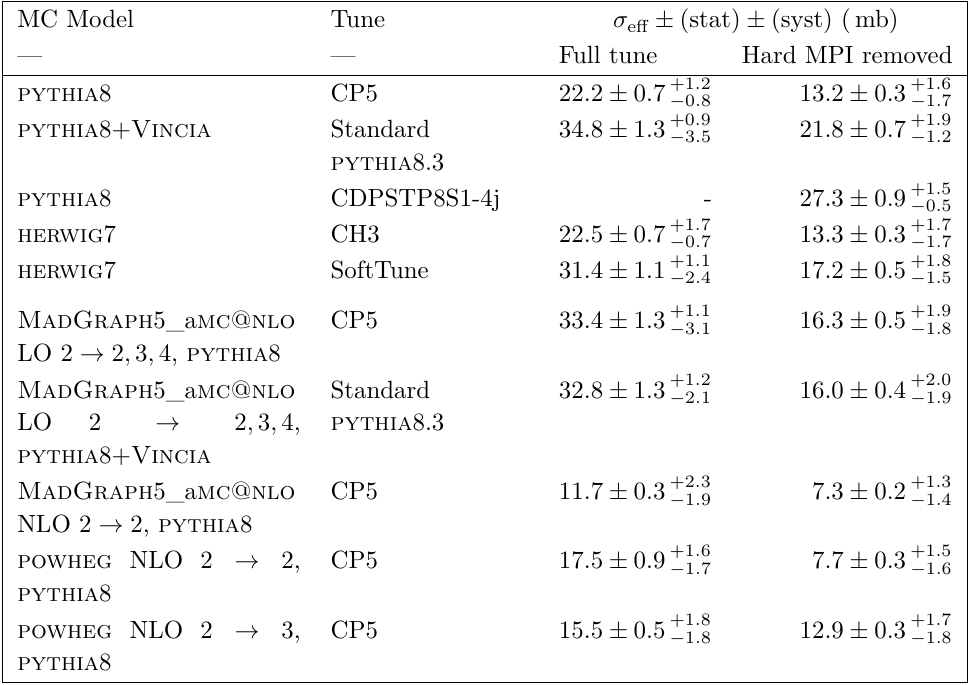
extracted from data using different SPS Table 8 . The values of the effective cross section σ eff models, along with their statistical and systematic uncertainties. The results are shown for the model where the full tune is used, and for the same models where the hard MPI have been